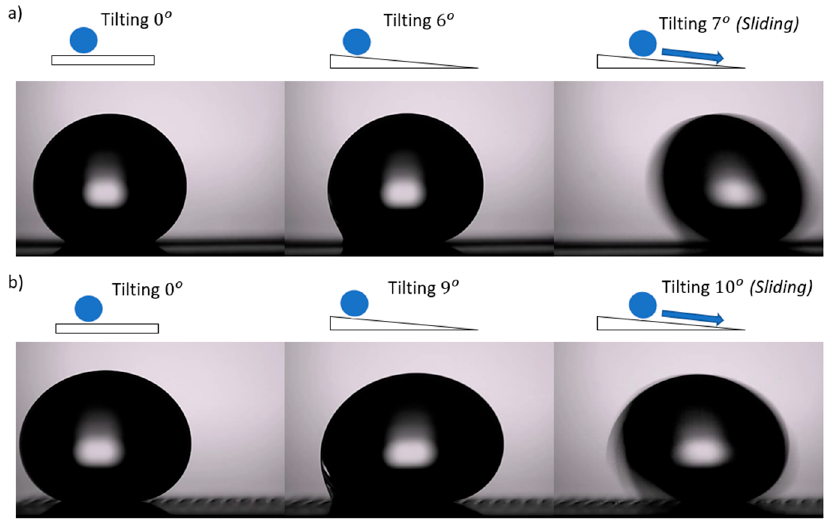
Figure 8. Sliding angle of the line-patterned sample at laser power 3 W with a 200-µm step size: ( a ) parallel direction, and ( b ) perpendicular direction.